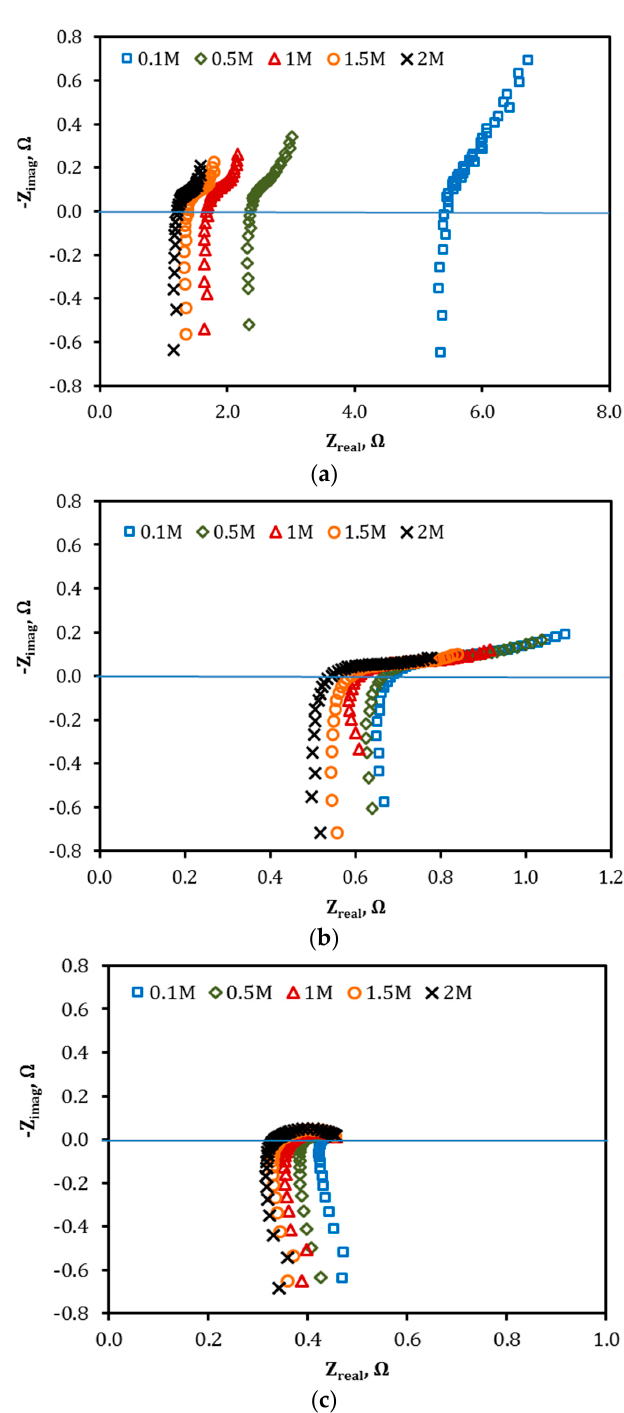
Figure 7. EIS measurements for the VRFB cell when equipped with ( a ) VPG ion separator, ( b ) Nafion-117 membrane separator, and ( c ) no membrane, and cell chambers filled with H 2 SO 4 solutions of various